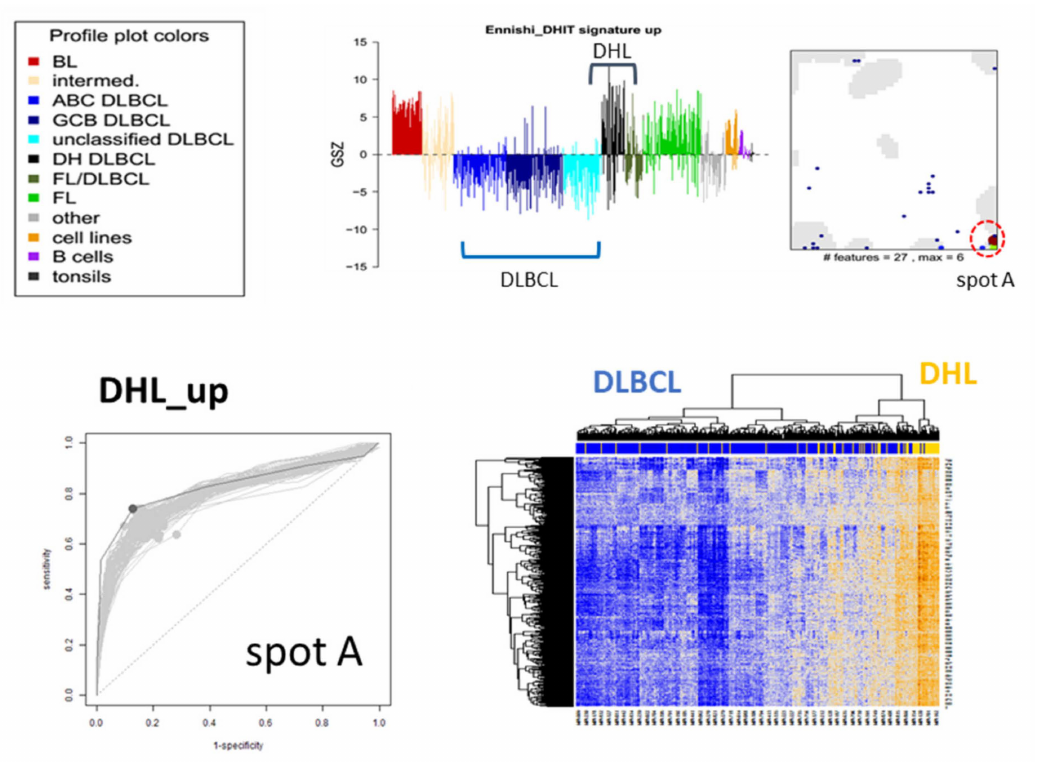
Figure A11. Characteristics of the DHL signature [5]. Note that this signature was designed for distinguishing DHL and DLBCL. Other subtypes such as BL and FL are shown here for illustration, particularly to show the joint BL and FL resemblance of DHL. The part below shows the resampling of genes from spot A as described in the legend of Figure